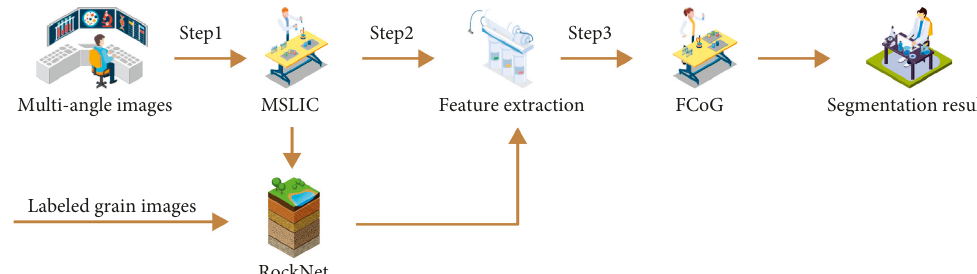
Figure 1: Framework of particle segmentation method for sandstone